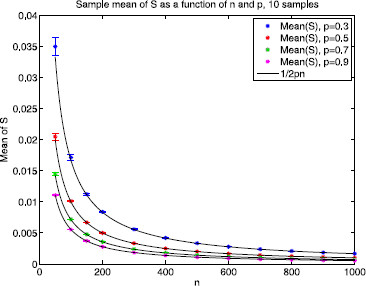
Approximating the sum S. Numerical evidence showing that the mean of S=1(n−1)2∑i=2n∑j=2n(−1λi+λj) is well approximated by 1/(2pn), for the Erdös–Rényi ensemble with p≥0.3. For a given value of p, the colored asterisks show the sample mean of S as a function of n over 10 realizations (with error bars showing the standard deviation) and the black curve is 1/(2pn)